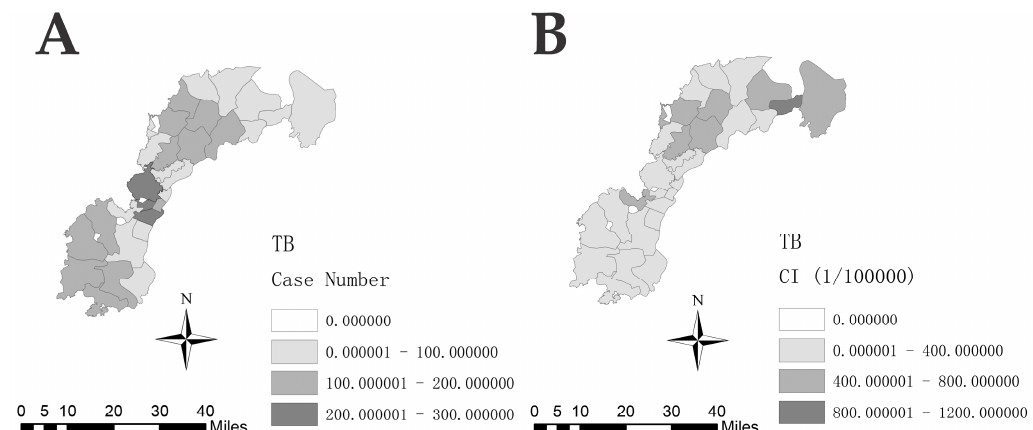
Figure 3. Spatial distribution of tuberculosis cases in the new urban area of Nanchang, 2010–2018. ( A ) Spatial distribution of TB cases. ( B ) Cumulative incidence of TB cases.